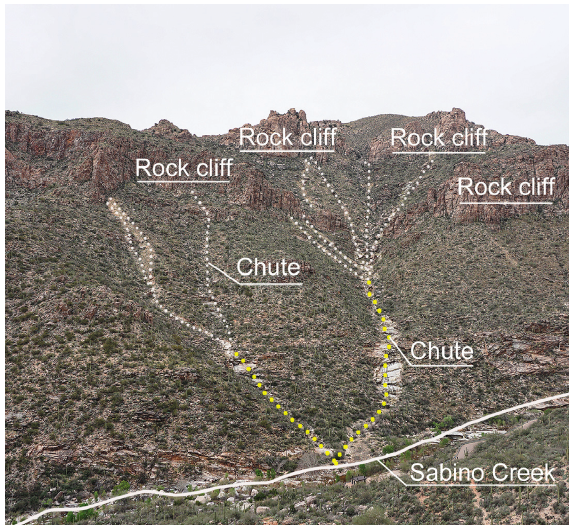
Figure 4: A large chute that passed the debris flows with its multiple, steep talus slope initiation points.